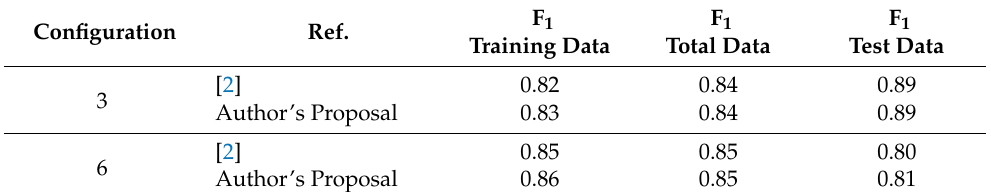
Table 9. Harmonic mean (F 1 ) for configurations with the best RS